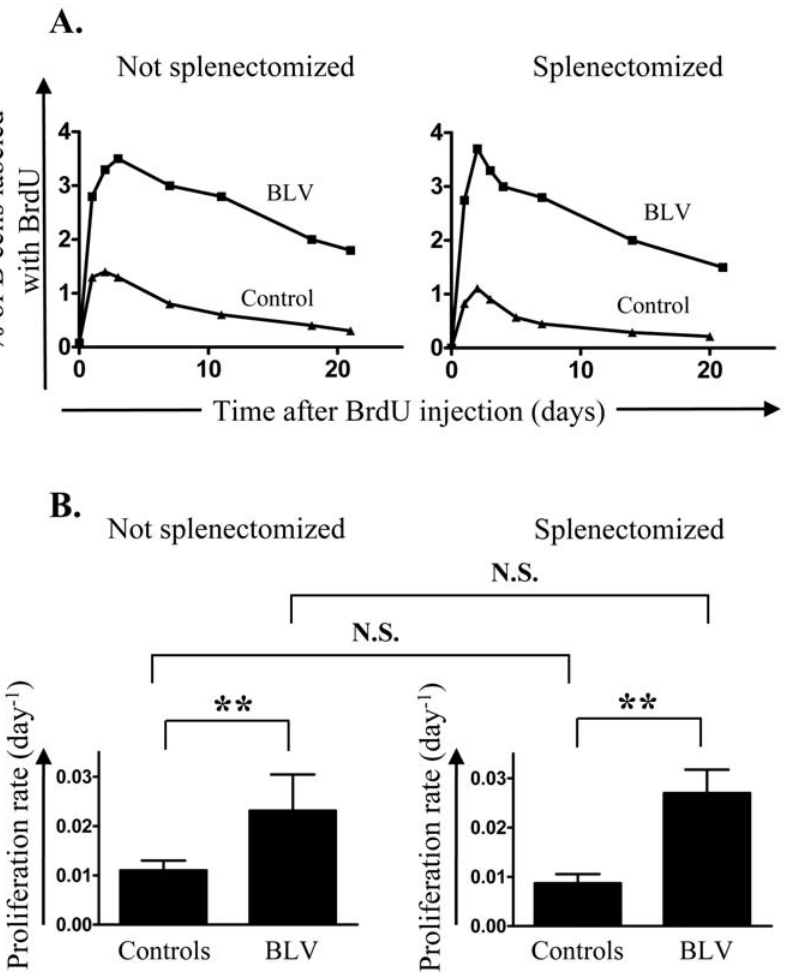
Figure 1. Evaluation of proliferation rates in vivo. BrdU was injected intravenously in BLV infected sheep and in non infected controls. At regular interval of time, the percentage of B lymphocytes having incorporated BrdU was determined by flow cytometry. A mathematical model was fitted to in vivo BrdU labeling data in B lymphocytes and proliferation rates were estimated. Not splenectomized (left panels) and splenectomized (right panels) animals were analyzed. (A) Percentage of B cells having incorporated BrdU in BLV-infected ( & ) and control ( m ) sheep. (B) Mean values ( 6 SD) of proliferation rates. BrdU was injected in 13 infected sheep, 4 of them being splenectomized and 6 controls, 3 of them being splenectomized. Statistical relevance (n.s., not significant; p , 0.01, highly statistically significant**) was calculated according to the unpaired two-tailed student t test with Welch’s correction.